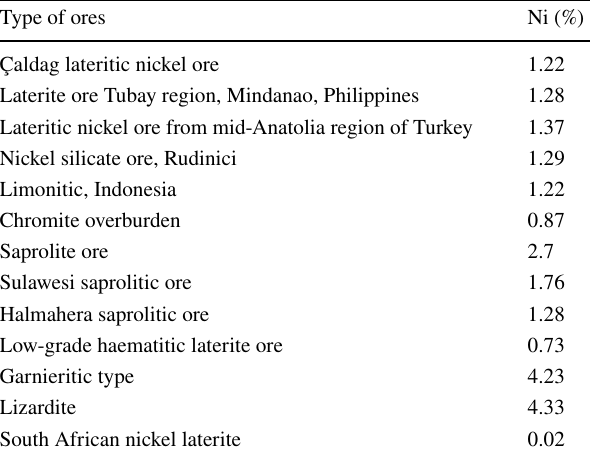
Table 1 Nickel content in silicates and oxides minerals (Meshram et al.